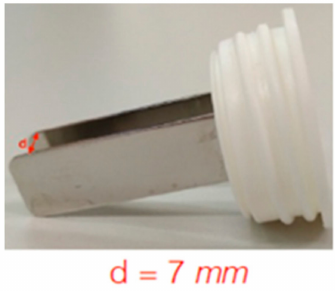
Figure 2. The electrode used in